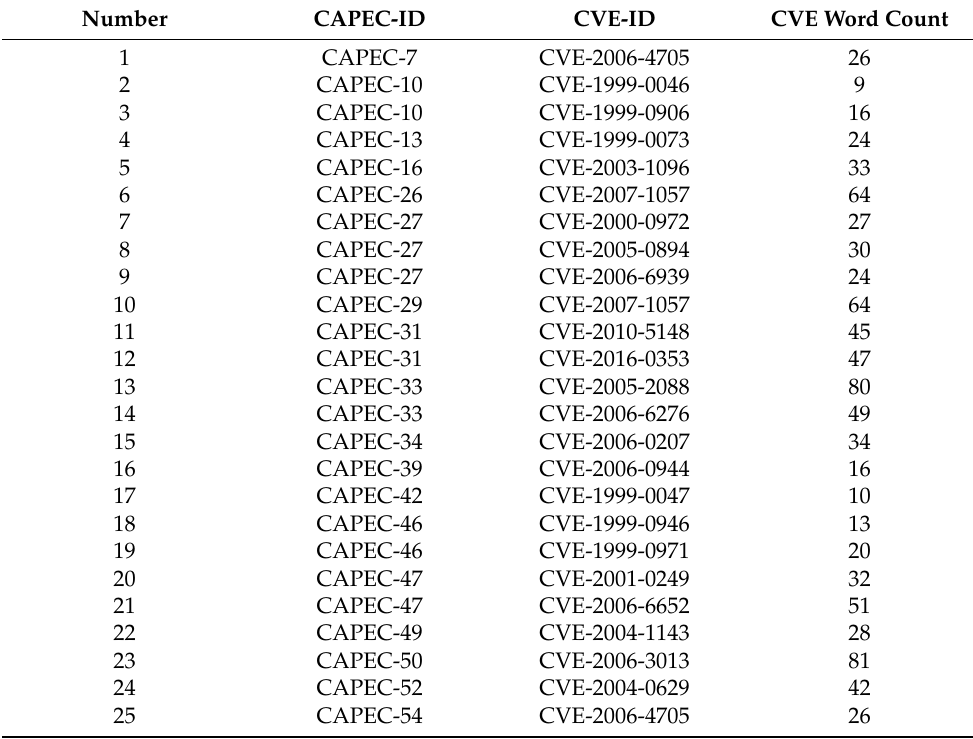
Table A1. List of 58 CVE-IDs and their corresponding